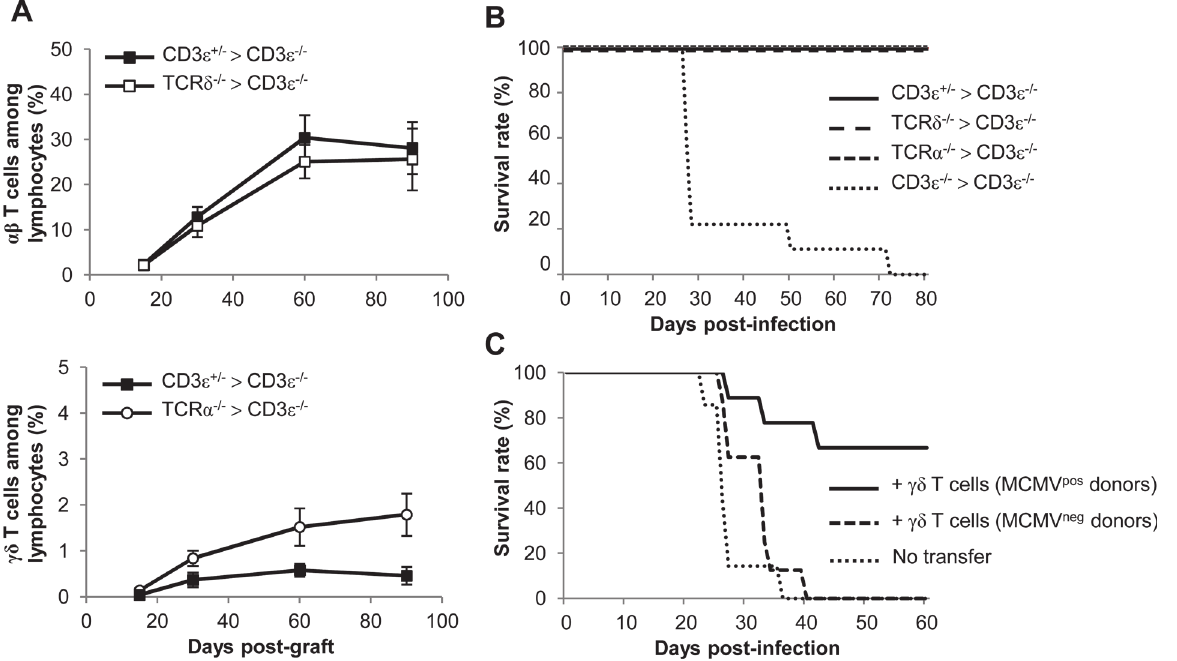
Fig 6. γδ T cell recovery rescues CD3 ε − / − mice from MCMV-induced death. A. Bone marrows (BM) from TCR δ − / − , TCR α − / − , CD3 ε +/ − and CD3 ε − / − mice (10 of each) were transferred into CD3 ε − / − recipient mice at day 0 (1 donor BM/recipient). At days 15, 30, 60 and 90, blood samples were collected (5 for each grafted mouse line) in order to follow αβ / γδ T cell reconstitution in peripheral blood. The evolution of the proportions of αβ T cells in CD3 ε +/ − > CD3 ε − / − and TCR δ − / − > CD3 ε − / − mice are shown (top) as well as the evolution of γδ T cells in CD3 ε +/ − > CD3 ε − / − and TCR α − / − > CD3 ε − / − mice (bottom). Results are expressed as percentages among peripheral blood lymphocytes ± SD. B. Three months post-graft, CD3 ε +/ − > CD3 ε − / − , TCR α − / − > CD3 ε − / − , TCR δ − / − > CD3 ε − / − and CD3 ε − / − > CD3 ε − / − mice (10 of each) were infected i.p. with 2.10 3 PFU of MCMV and monitored daily for mortality. This experiment was repeated twice with concordant results. C. γδ T cells from uninfected or 14-days infected TCR α − / − mice were purified and i.v. transferred (8 – 9.10 5 cells, 92 – 93% purity) into CD3 ε − / − mice (8 – 9 recipients). 24h after transfer, reconstituted CD3 ε − / − mice were challenged with 2.10 3 PFU of MCMV and monitored daily for mortality. 7 untransferred CD3 ε − / − were used as controls. This experiment was repeated twice.